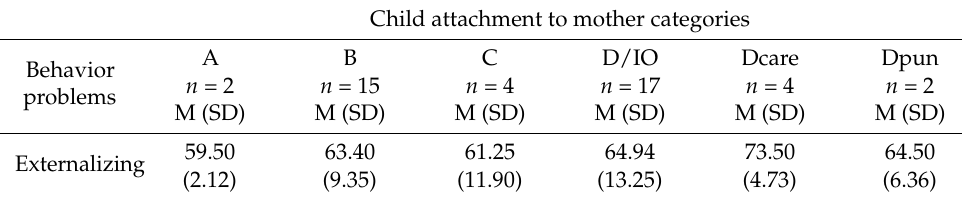
Table 4. Child externalizing behavior (T-score) as a function of child attachment to mother categories.